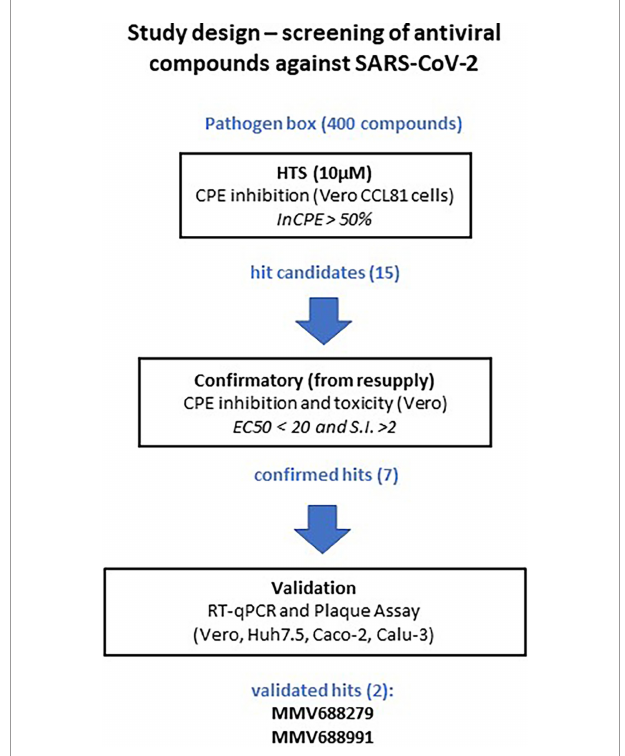
FIGURE 1 | Study design for the high-throughput screening of MMV compound collections against SARS-CoV-2 in vitro . A total of 400 compounds present in MMV Pathogen Box were screened at 10 µM for the ability to inhibit virus-induced cytopathic effect (InCPE). Compounds that presented at least InCPE > 50% (15 compounds) were considered hits and progressed to con fi rmatory tests after resupply. Dose-response curves were performed and compounds that showed a half maximal effective concentration (EC50) below 20 µM and a selectivity index (SI) above 2 progressed to validation. The antiviral properties of 7 hit compounds were evaluated in different cell lines (Vero, HuH 7.5, Caco-2 and Calu-3) infected with SARS-CoV-2, leading to validation of MMV688279 and